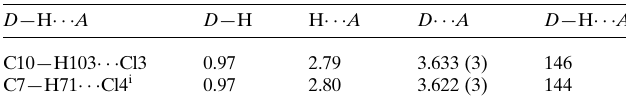
Table 2 Hydrogen-bond geometry (A˚ , (cid:2) ) for 1 .